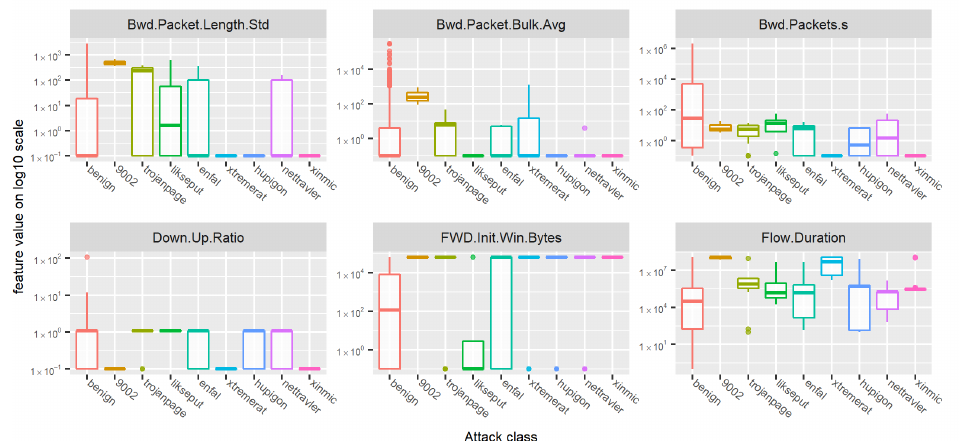
Figure 5. Boxplots for different features—part 1.